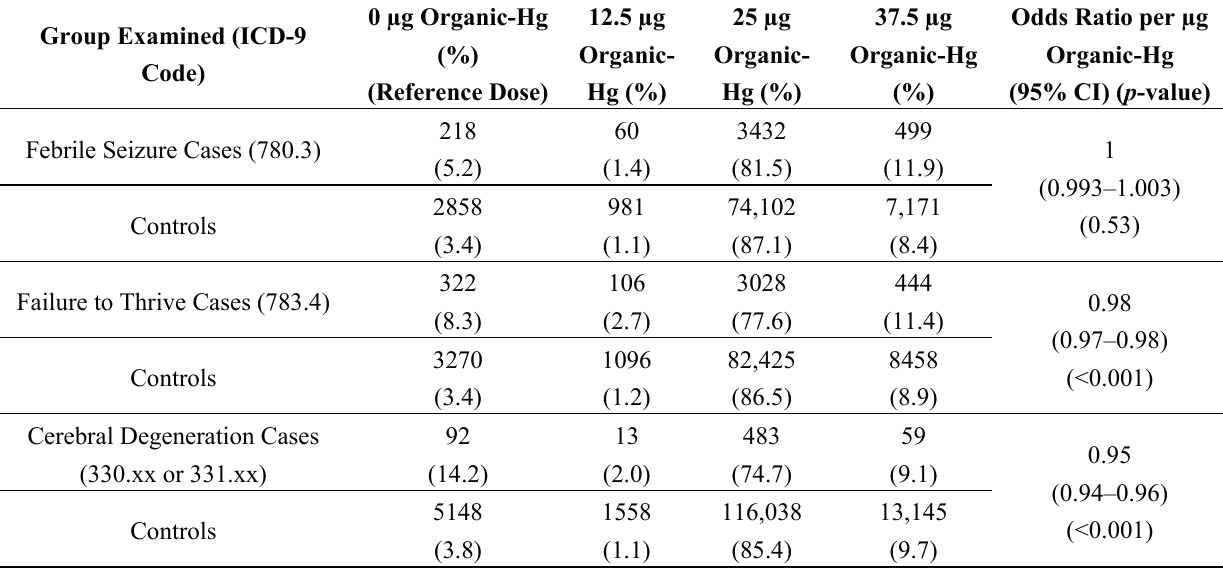
Table 4. A summary of exposure to organic-Hg from thimerosal-containing hepatitis B vaccine administration within the first six months of life between the cases diagnosed with medical conditions a priori not biologically plausibly linked to postnatal organic-Hg exposure from thimerosal-containing vaccines and the controls.